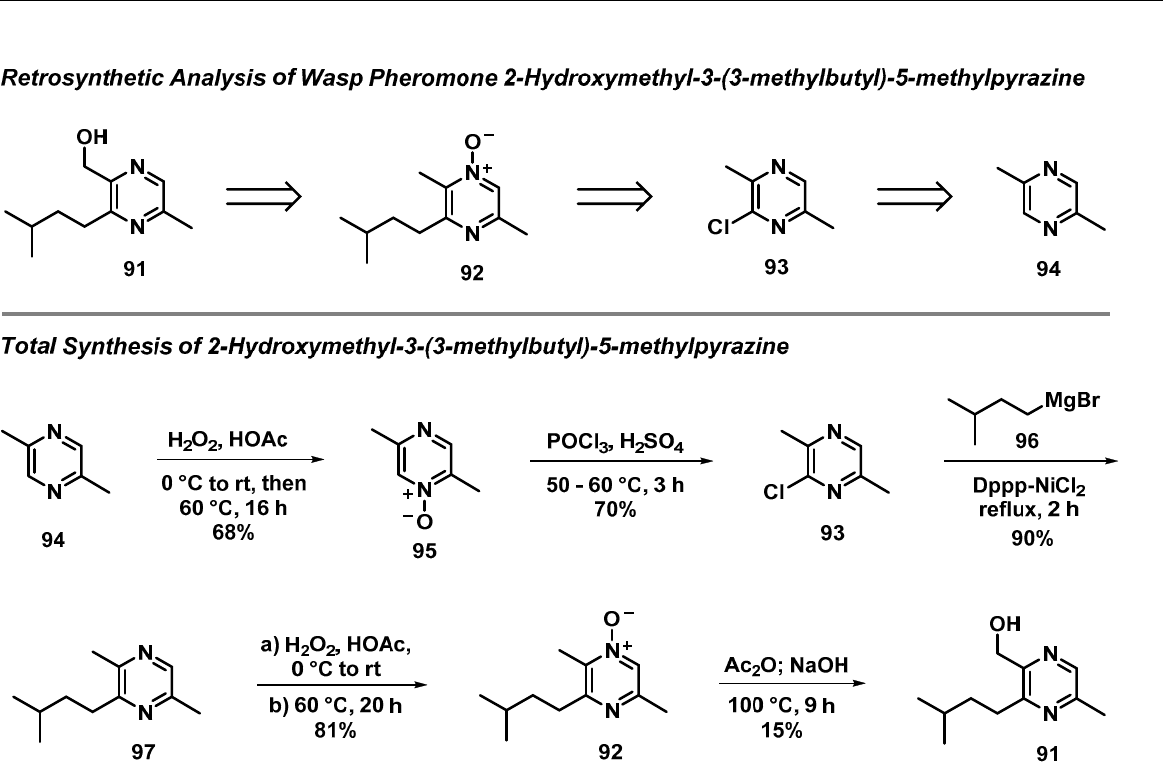
Scheme 8. Barrow’s synthesis of 2-hydroxymethyl-3-(3-methylbutyl)-5-methylpyrazine ( 91 ) via